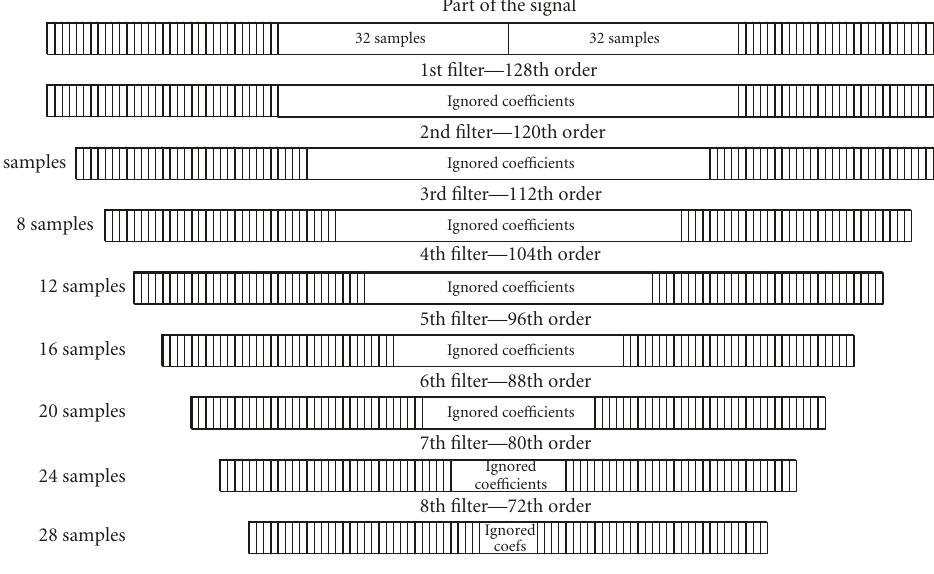
Figure 7: Example of filterbank